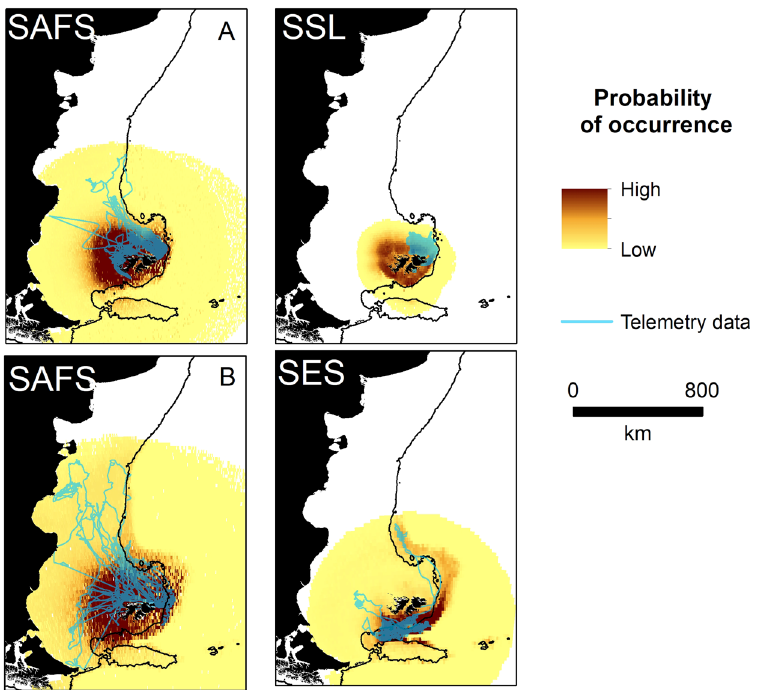
Figure 3. Pinniped predicted habitat use (probability of occurrence, proportional to the likelihood of absences) at the Falkland Islands and available biotelemetry and biologging data (blue line). SAFS = South American fur seal A = winter, B = Spring, SES = southern elephant seal, SSL = southern sea lion. See Supplementary Material Fig S3 for species predictions weighted by